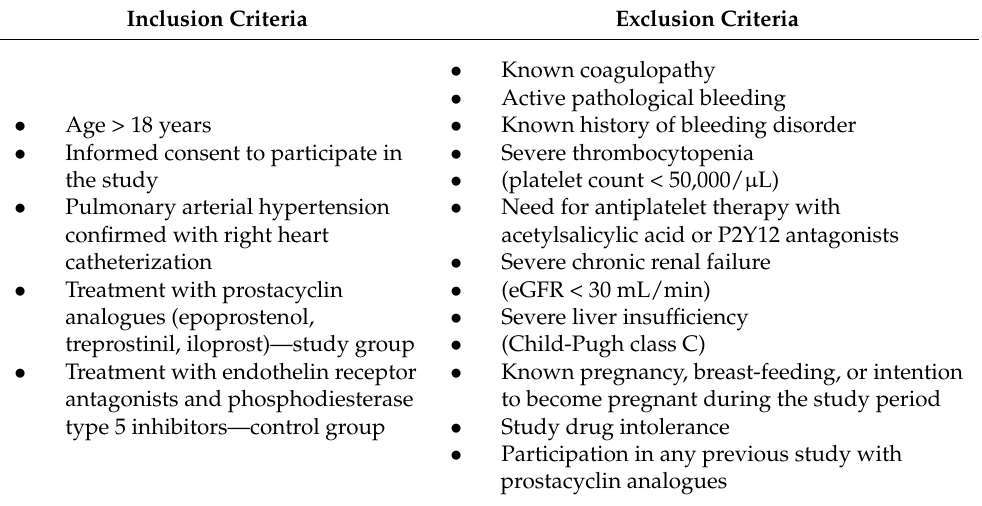
Table 1. Study inclusion and exclusion criteria. eGFR—estimated glomerular filtration rate. Inclusion Criteria Exclusion